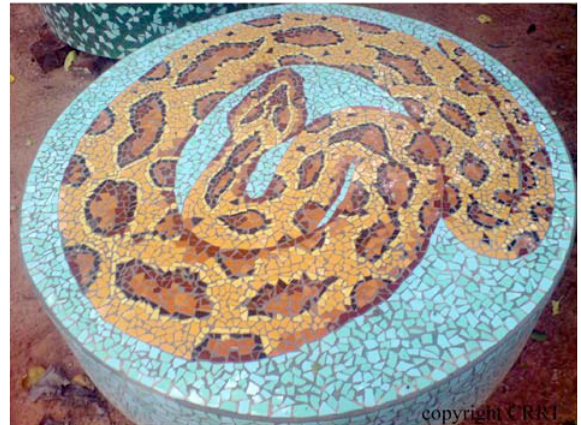
Image 15. Richness of colour is one feature of mosaic work that cannot be equaled by any other media. The cement ring which is used for seating is adorned by a Russell’s Viper Daboia russelli . Tholkappia Poonga, Chennai.